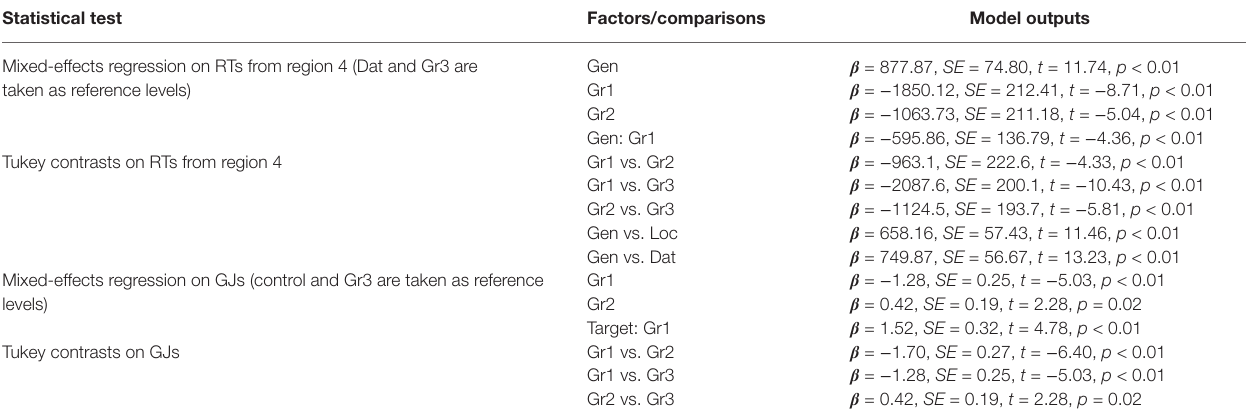
TABLE 5 | All L2 groups: model outputs for RT and GJ analyzes. Statistical test Factors/comparisons Model